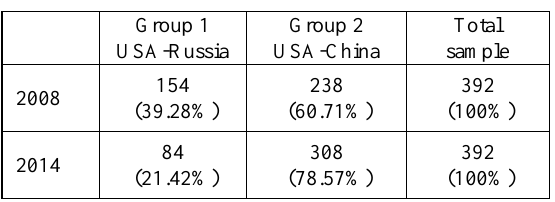
Table 4: Sample Size according to Groups of Countries Group